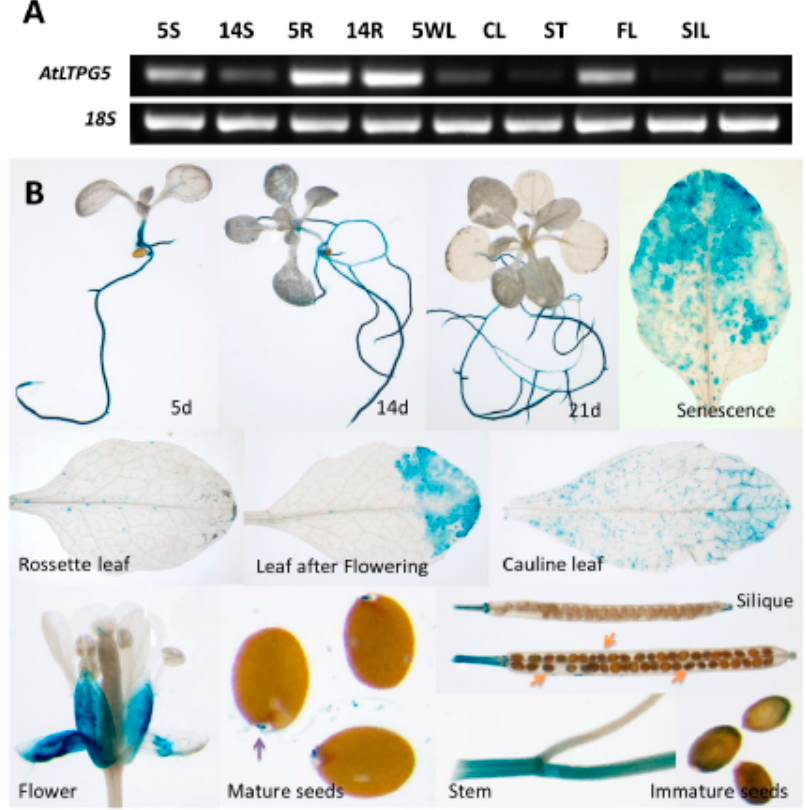
Figure 7. Expression analysis of di ff erent plant part and growth stages. ( A ) Reverse transcriptase PCR (RT-PCR) for the developmental regulation of LTPg5. RT-PCR using RNA isolated from seedlings grown on MS-medium (5S, 5-d-old shoots; 14S, 14-d-old shoots; 5R, 5-d-old roots; 14R, 14-d-old roots) or from plants grown on soil (5WL, 5-w-old leaves; CL, cauline leaves; ST, stems; FL, flowers; SIL, siliques). Primers for the 18S gene were used for control reactions. ( B ) LTPg5 promoter activity in plant parts determined with GUS fusion. In mature seeds, micropylar endosperm gave strong staining.